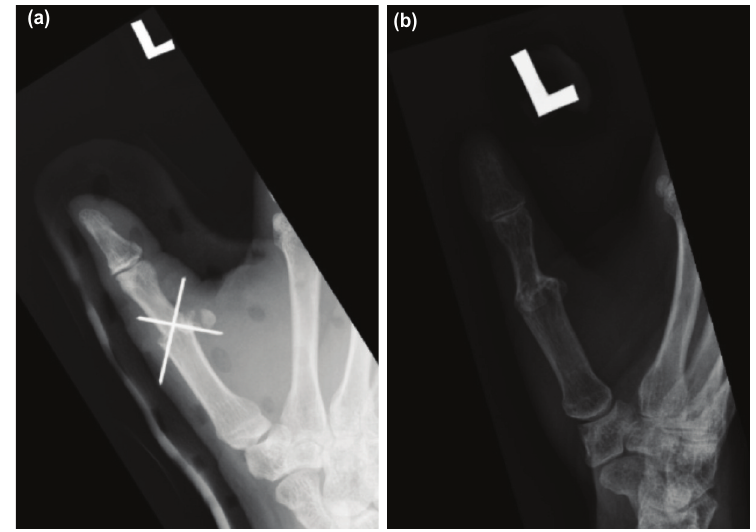
Radiographs of left thumb anteroposterior view (a) day 2 and (b) 1 year post-surgery. Fig. 2: